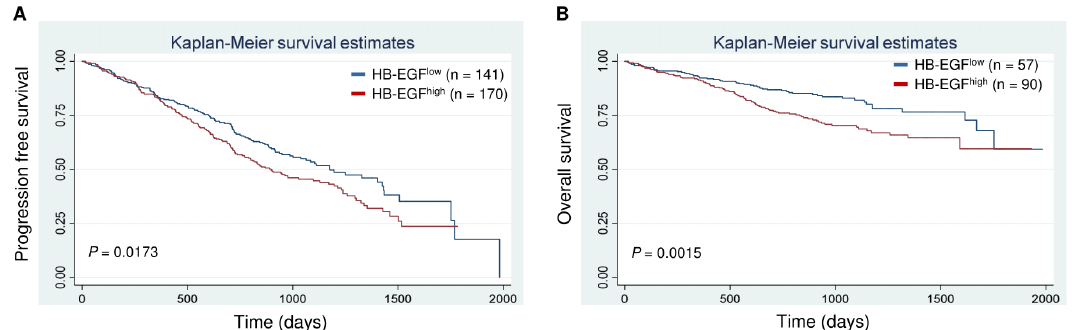
Figure 7. HB-EGF expression predicts survival in MM patients. Kaplan–Meier survival curves for cases in the lowest vs. highest quintiles of HB-EGF expression among 647 patients of the MMRF cohort (https://research.themmrf.org). Patients with higher HB-EGF expression have shorter progression-free survival ( A ) and overall survival ( B ) Log-rank test.